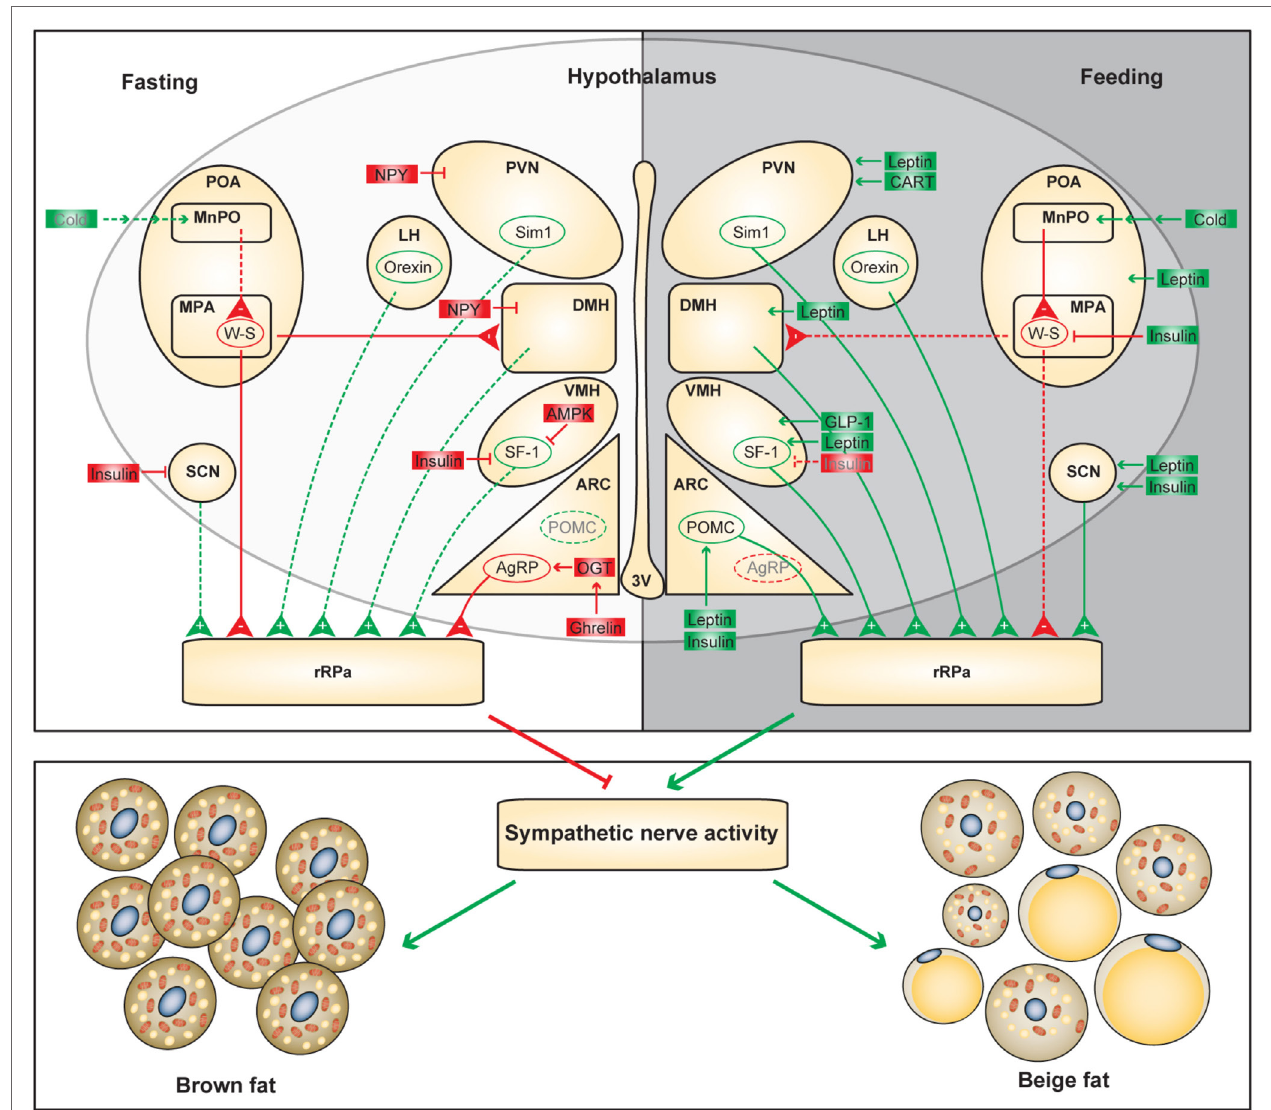
FiGURe 1 | Functional neuroanatomical model of the hypothalamic control of adaptive thermogenesis . Differential regulation of the hypothalamic circuits during fasting and feeding is shown. Positive and negative regulators of the adaptive thermogenesis are shown in green and red, respectively. Dashed lines and gray letters indicate inactive or diminished